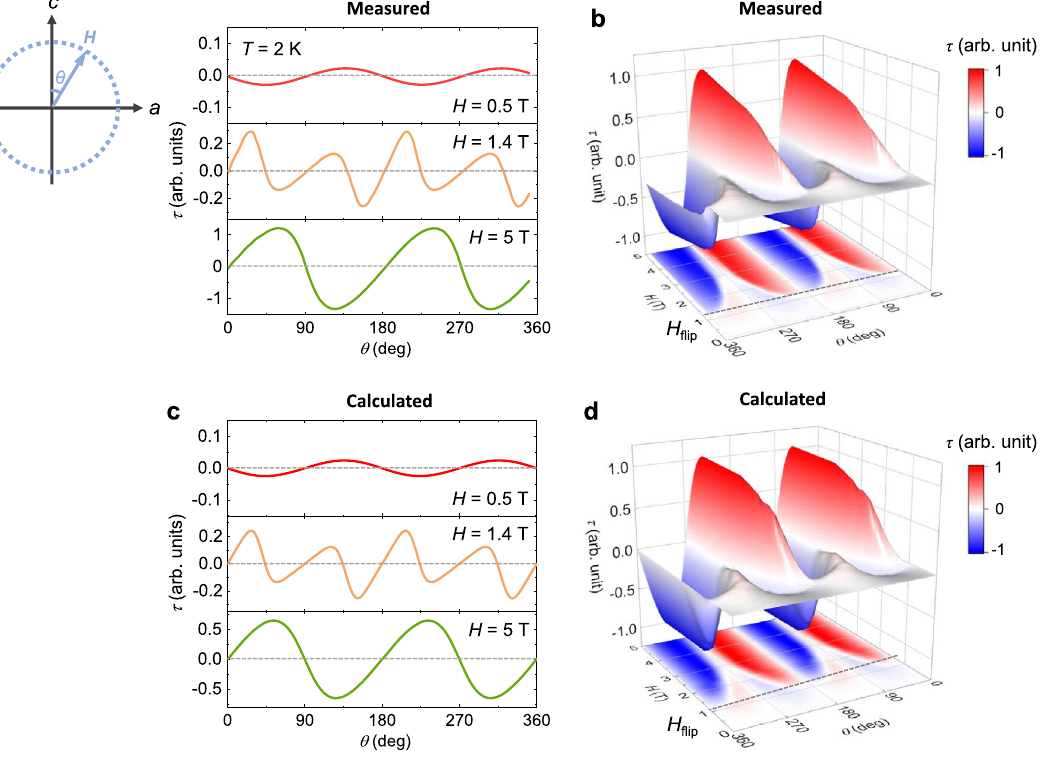
Figure 4. Measured and calculated magnetic torques at 2 K. ( a ) Angle dependence of the magnetic torque per unit volume, τ = M × H , measured at T = 2 K by rotating H in the ac plane at H = 0.5, 1.4, and 5 T. As shown in a schematic, θ is deviated from the c -axis. The scale of τ at 5 T is ten times greater than that at 0.5 T. ( b ) 2D and 3D contour plots obtained from the angle-dependent τ data measured at various values of H and T = 2 K. The dotted line denotes the occurrence of a spin-flip transition, H flip = 1.2 T. ( c ) Calculated angle dependence of the magnetic τ at H = 0.5, 1.4, and 5 T. ( d ) 2D and 3D contour plots established from the calculated angle-dependent τ